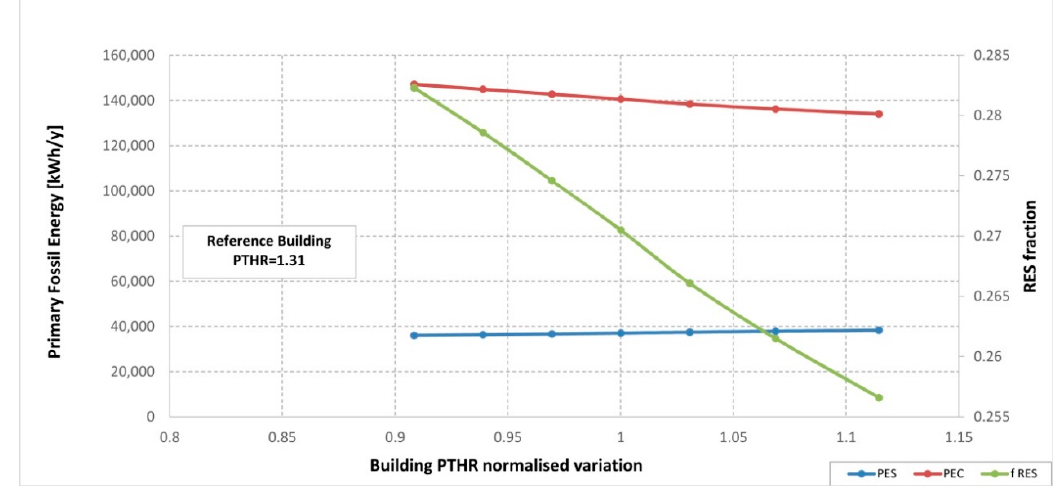
Figure 12. Performance indicator values with changes in building thermal loads.